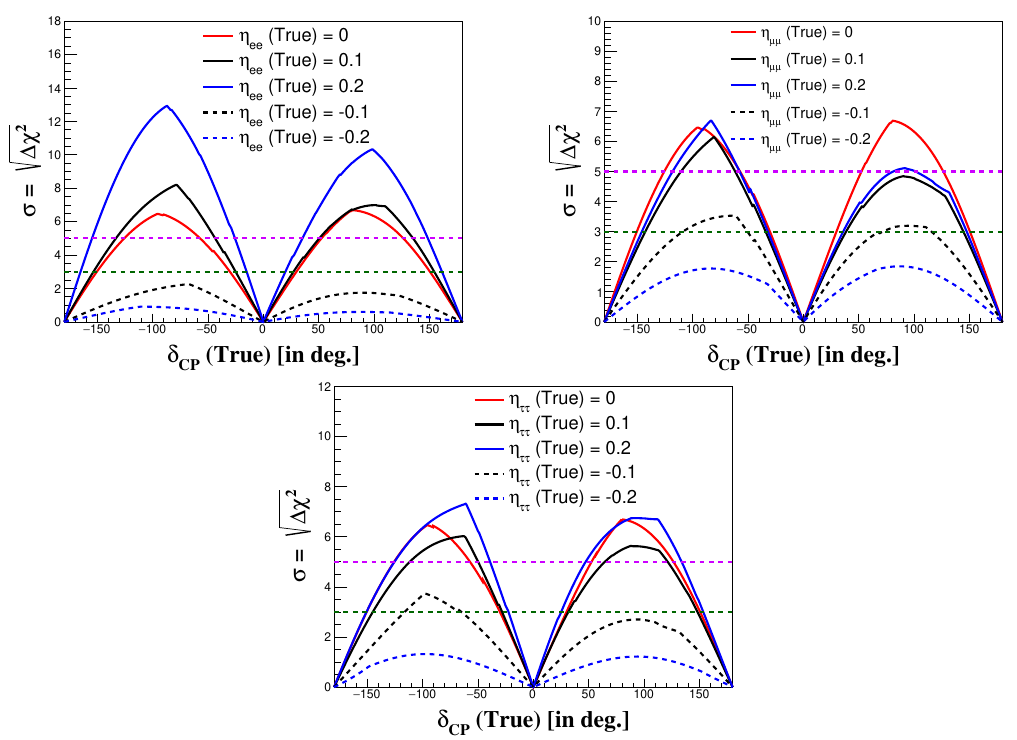
Figure 6 . The CP-violation sensitivity of DUNE in presence of scalar NSI element η αβ . The results for η ee (top-left panel), η µµ (top-right panel), and η ττ (bottom panel) are shown. In all the three plots, the red curve is for the ‘no scalar NSI’ case whereas the black and the blue solid (dashed) curves are for the chosen positive (negative) non-zero η αβ